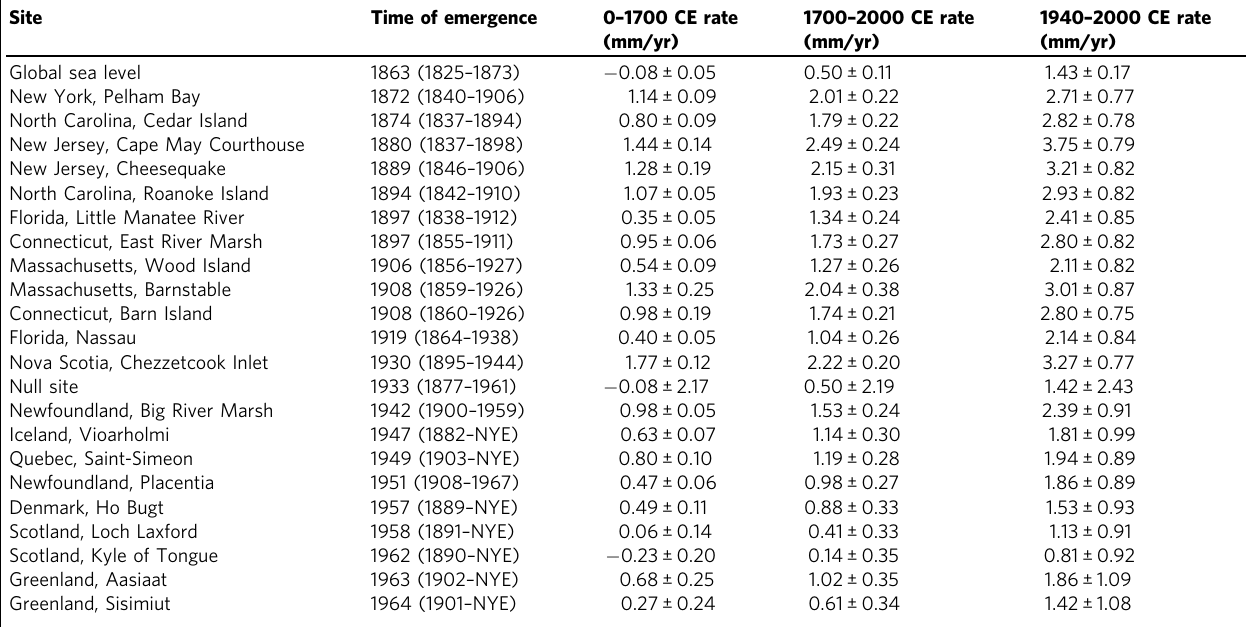
Table 1 Time of emergence and Common Era rates for global sea level, null site, and 21 North Atlantic sites.